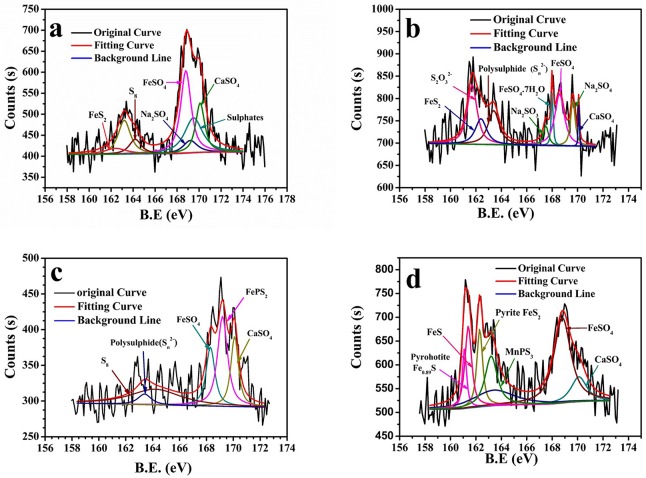
High-resolution O spectra of the corrosion product on the steel surface at various cathodic polarization potentials in SRB medium.a) OCP; b) -0.85VSCE; c) -0.95VSCE; d) -1.05VSCE.